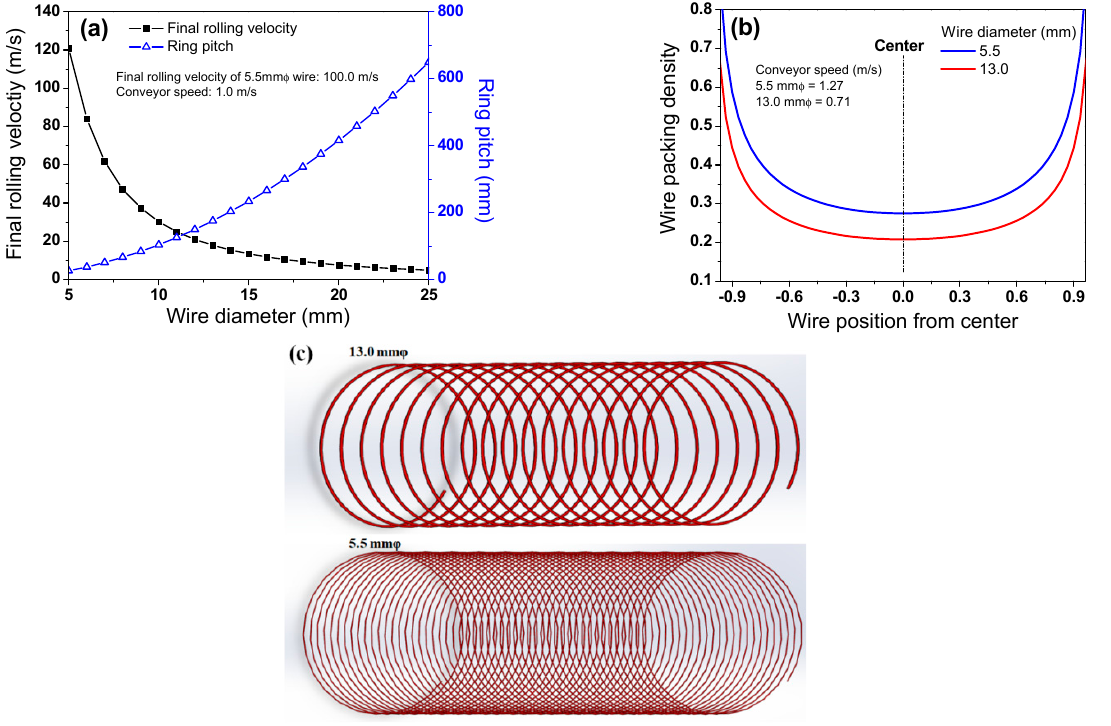
Figure 4. ( a ) Variations in final rolling speed and ring pitch with wire diameter and ( b , c ) comparison of wire packing density with wire diameter in a typical wire rod mill.